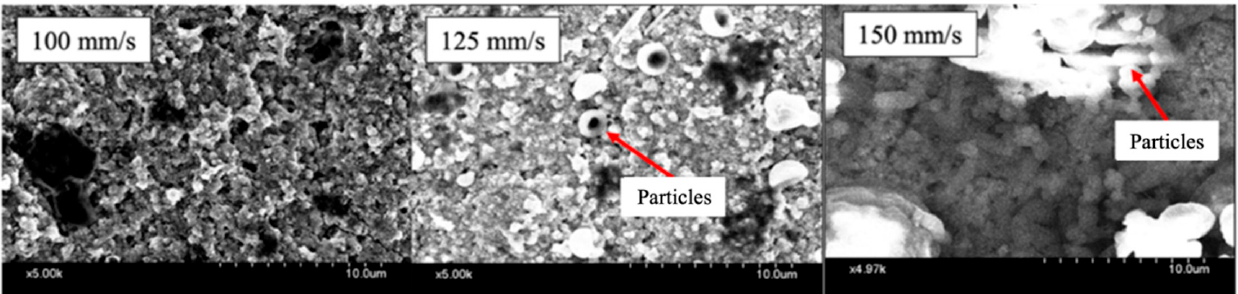
Figure 11. SEM morphologies of 1.5 W sintered thin films with varied scanning speeds.